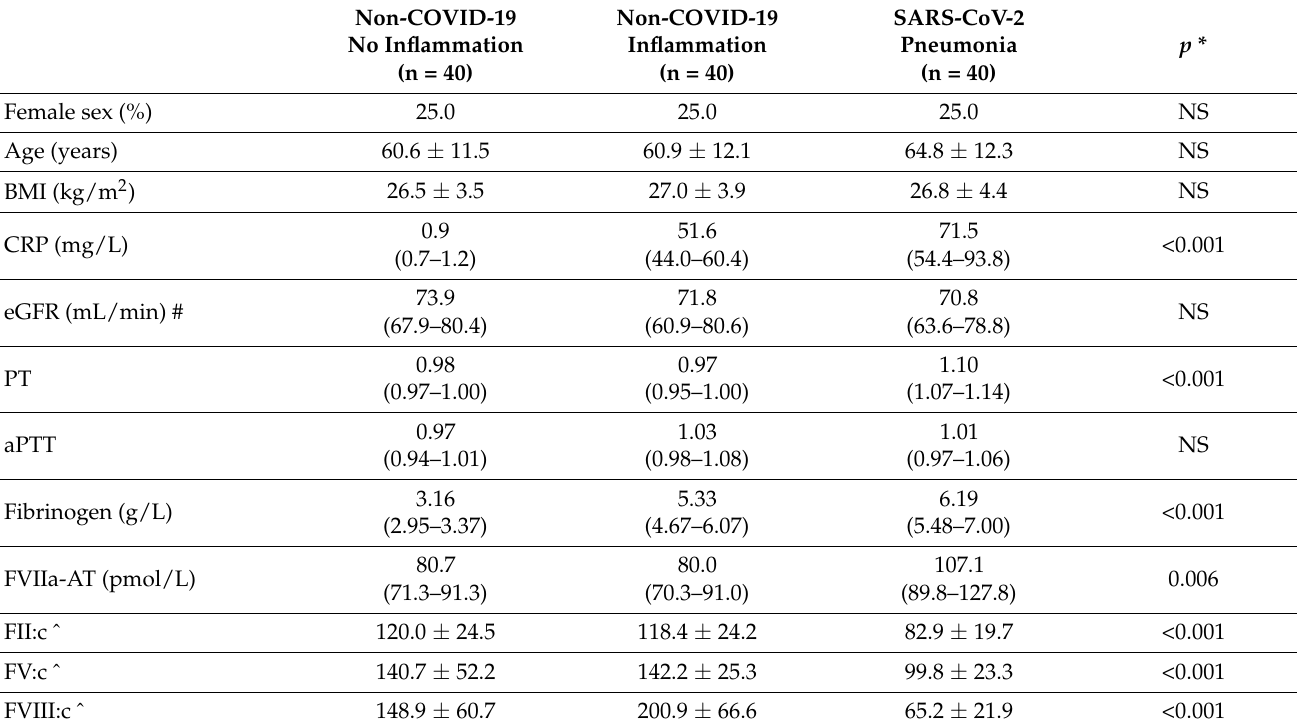
Table 1. Study cohort characteristics. Clinical and laboratory characteristics of the three study groups: (i) non-COVID-19 subjects without inflammation, (ii) non-COVID-19 subjects with inflammation, and (iii) subjects with SARS-CoV-2